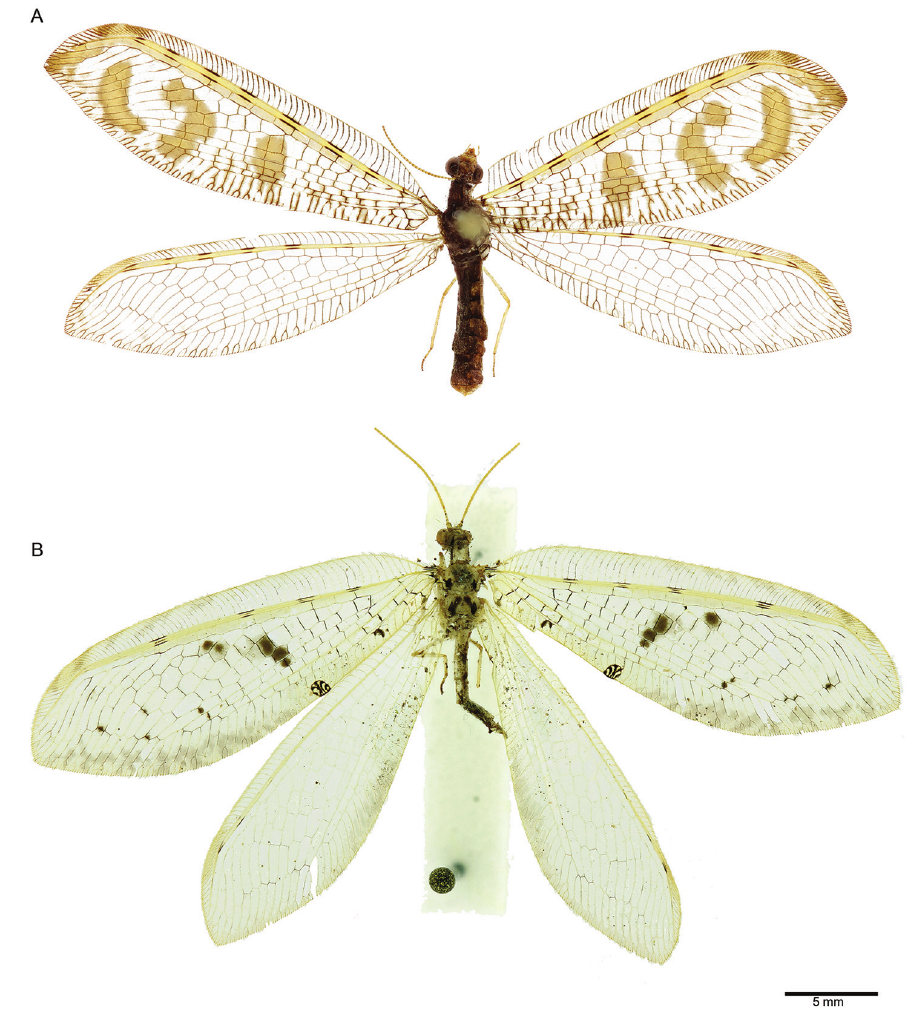
Figure 1. Spilosmylus spp., habitus: A Spilosmylus spilopteryx sp. n. B Spilosmylus tephrodestigma sp. n.